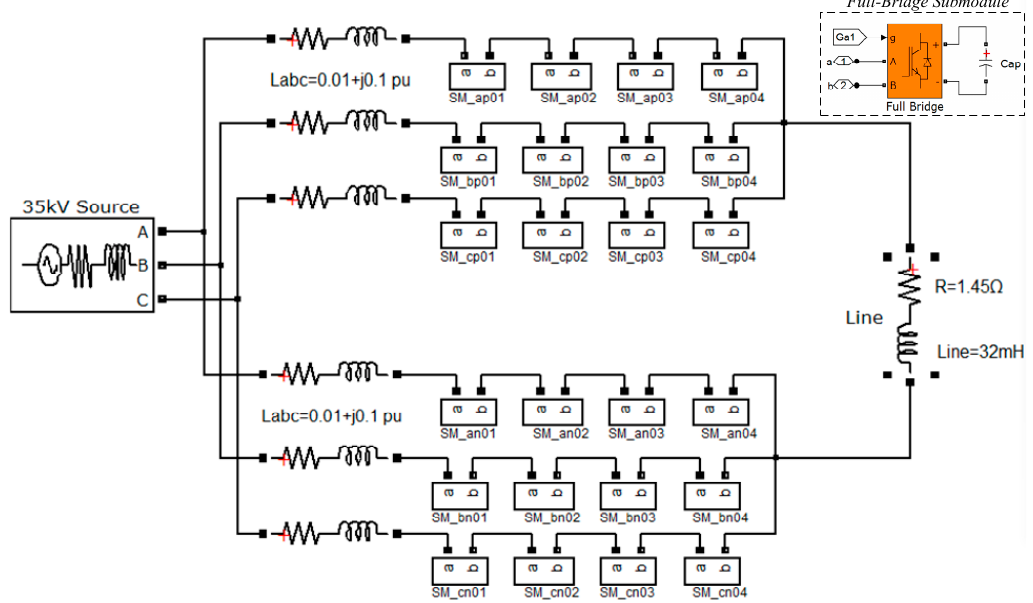
Figure A2. The circuit image of MMC-DDI simulation model built in Matlab/Simulink.